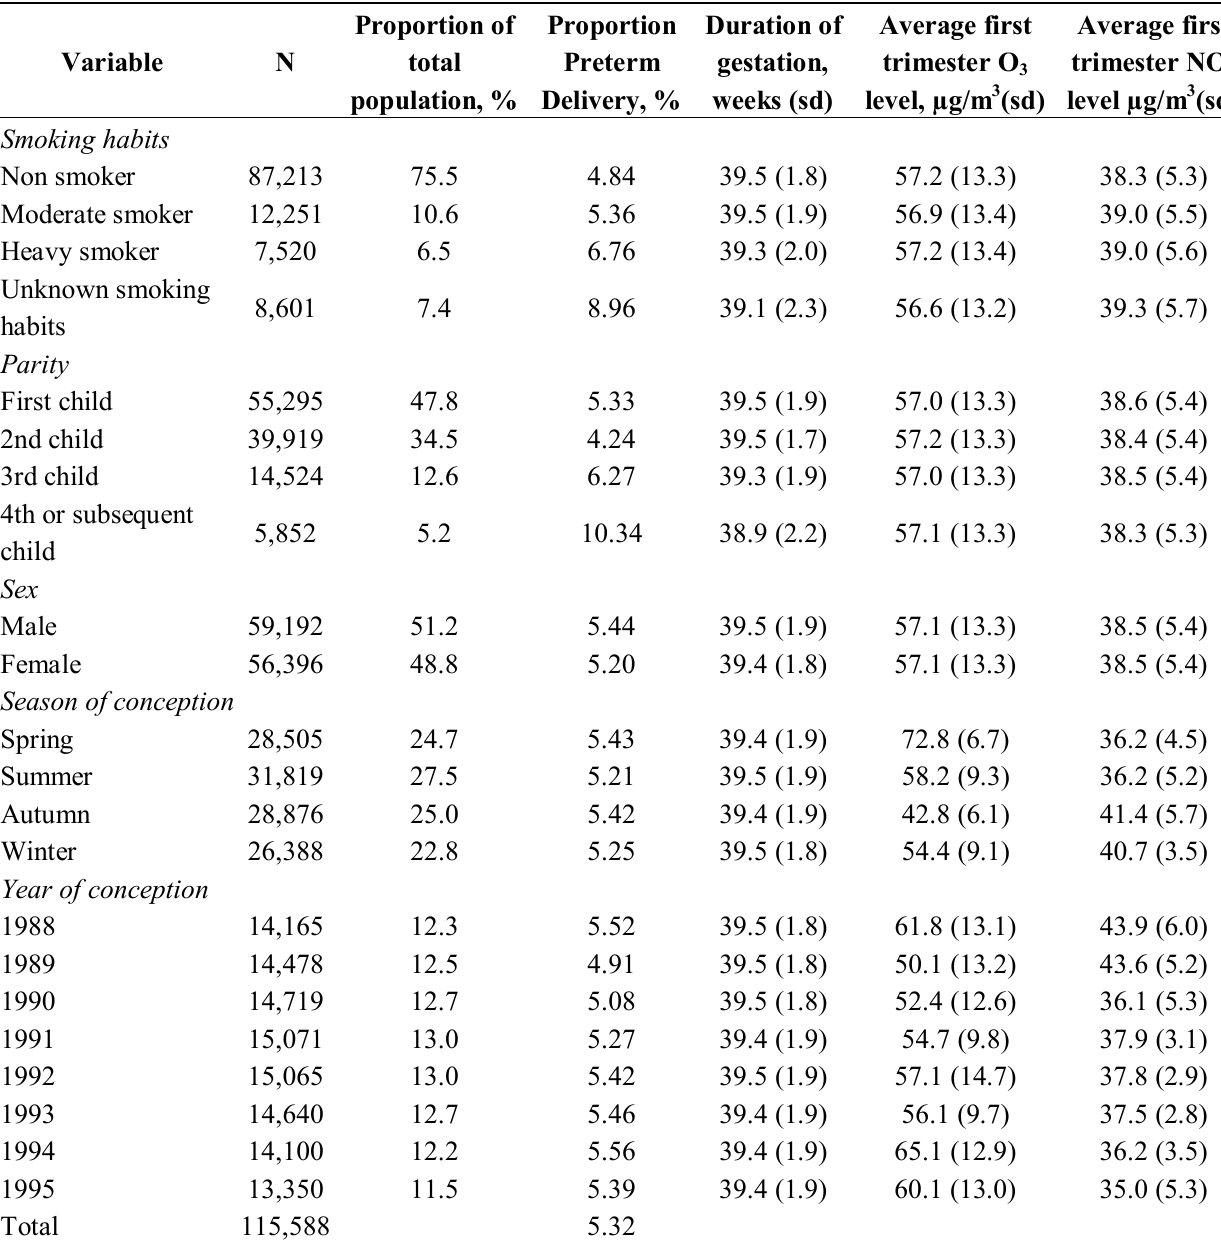
Table 3. Proportion preterm delivery within levels of covariates in the adjusted